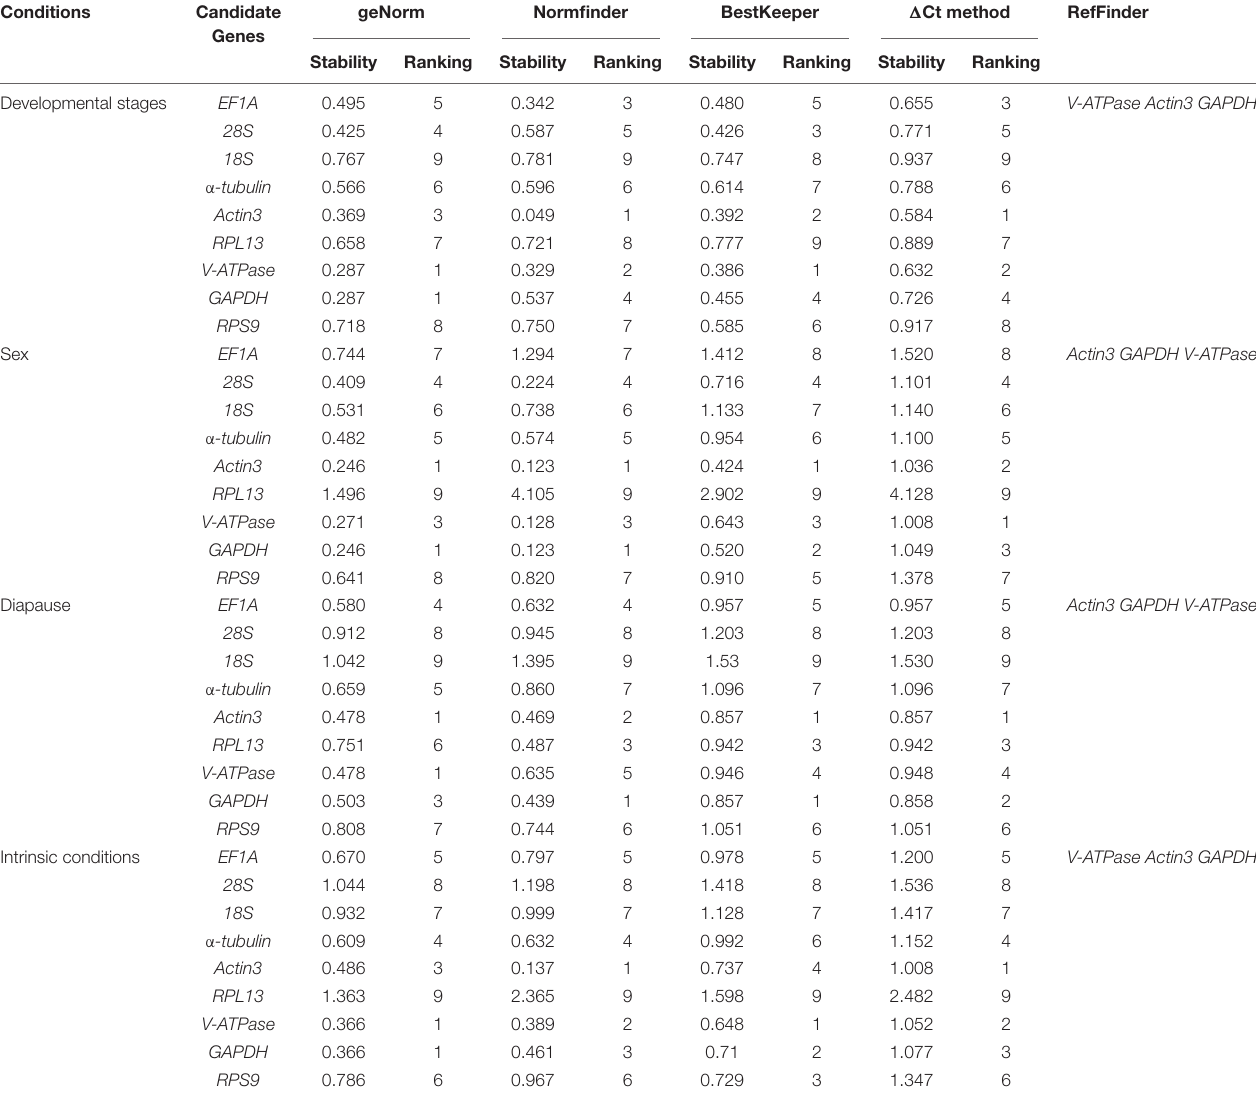
TABLE 3 | Stability of candidate reference genes under different intrinsic